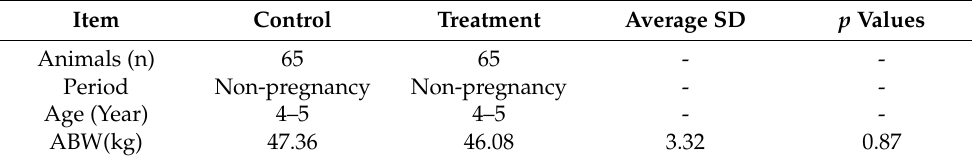
Table 1. Physiological statuses of goats selected for the experiment. Item Control Treatment Average SD